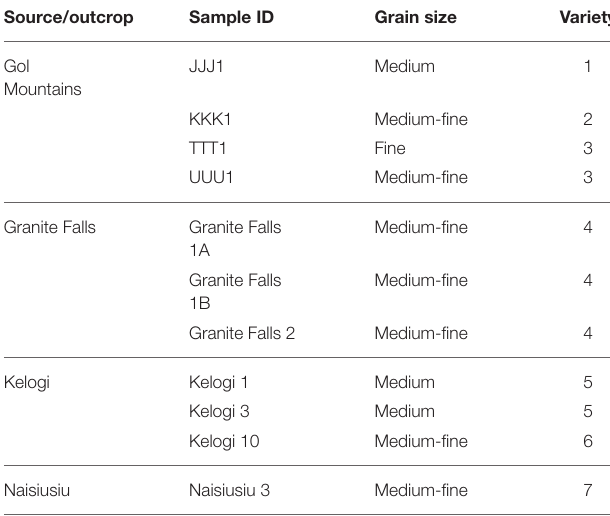
TABLE 5 | Meta-granite